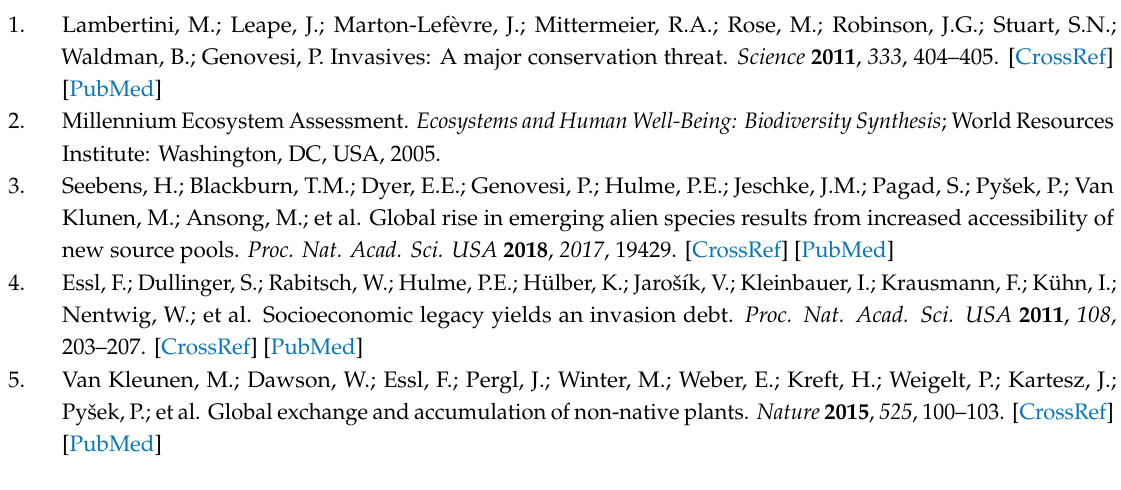
Figure S1: a) Map of the study area showing the location of the two sampling sites; right inset displays their position with respect to Italian peninsula; b) Details of the two sampling sites (right panel Site 1, left panel Site 2); red dots and lines represent the plots and the transects, respectively. Table S1: List of vascular plant species sampled in the study area. *denote invasive alien species, † denotes alien species which are naturalized. In bold the IAS shared between the two